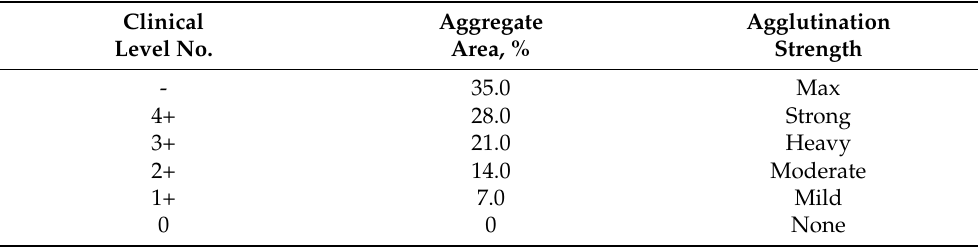
Table 1. Classification of clinical blood agglutination levels for immunostrip biosensors IMS-50 for test conditions developed in this